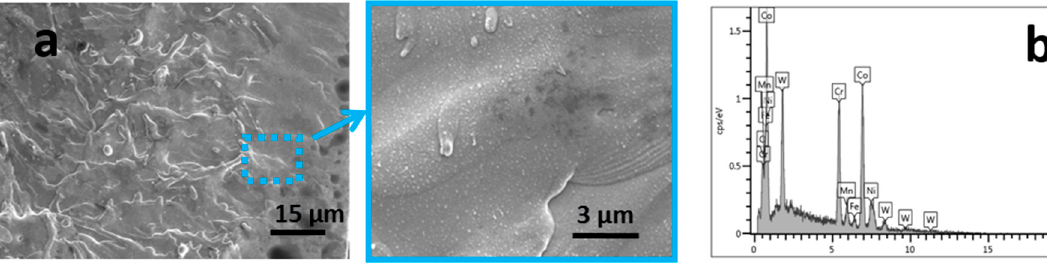
Figure 6. Kerf geometry and dross formation of the cuts before the acid pickling process: ( a ) oxygen cut; and ( b ) argon cut.